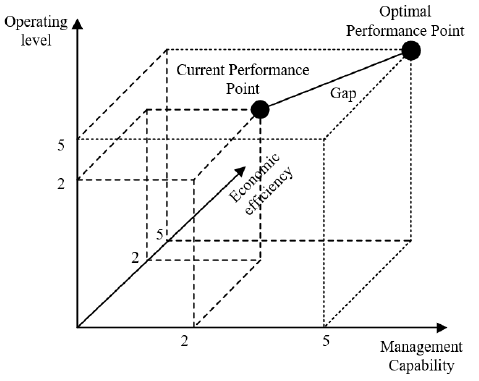
Figure 8. Schematic diagram of comprehensive evaluation space.